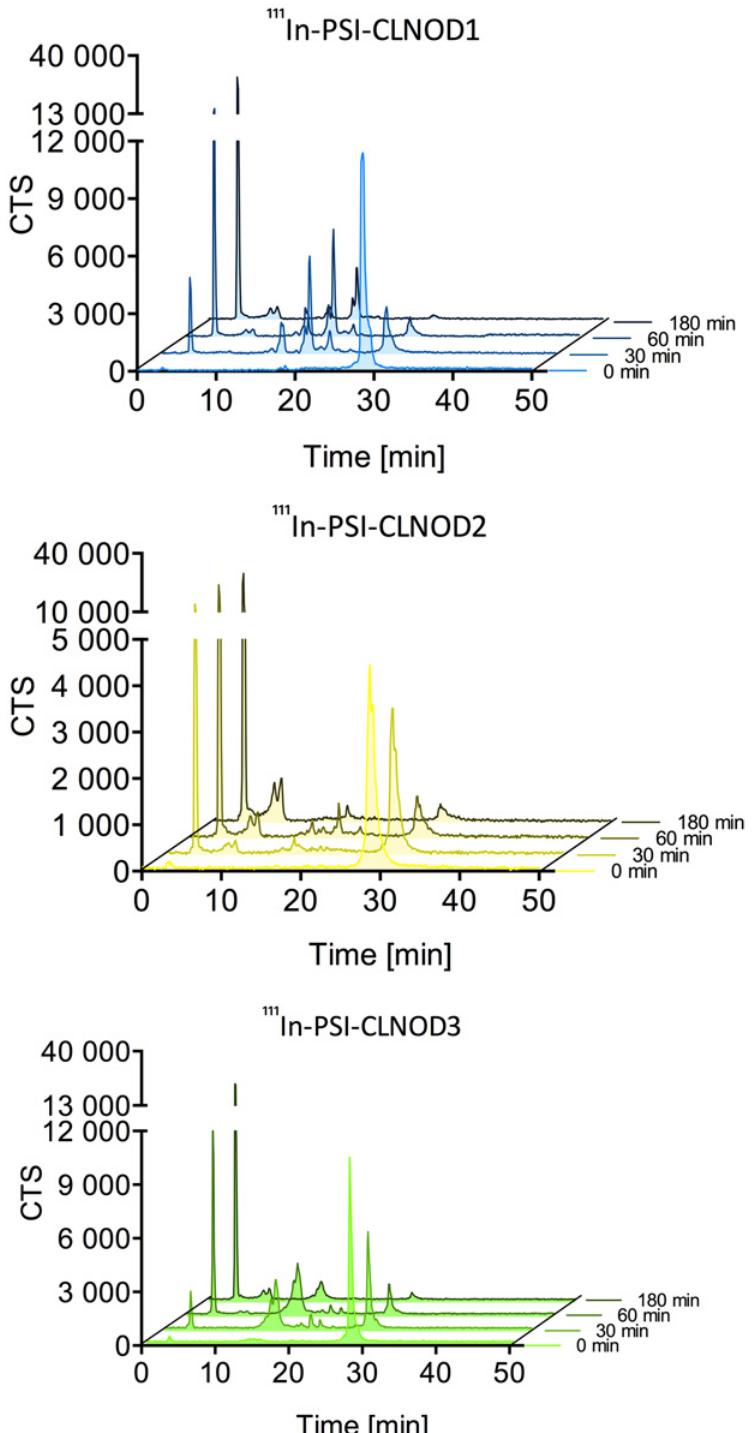
Fig 8. Ex vivo metabolism of the corresponding peptides in CD1 nu/nu kidney homogenates.